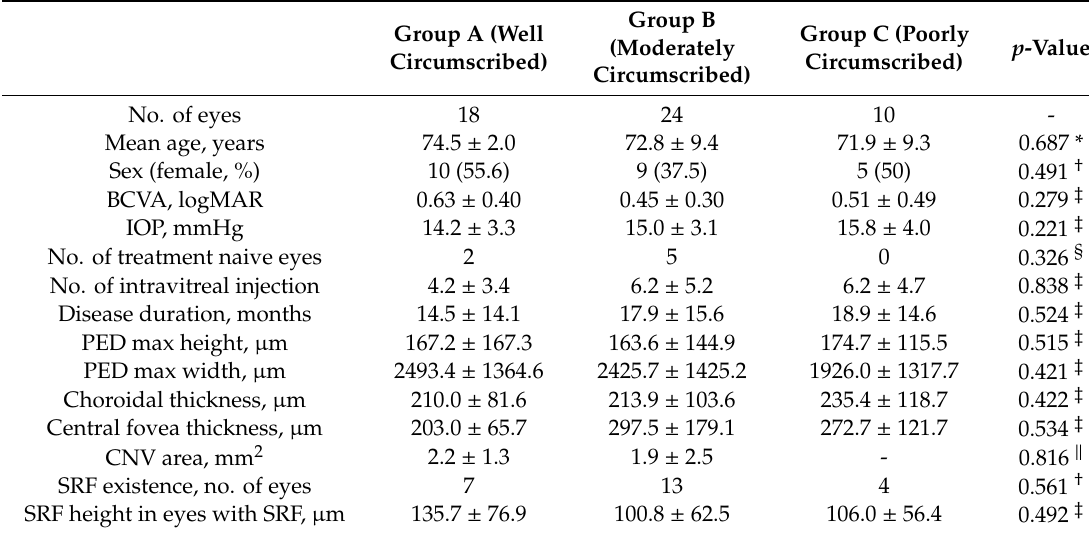
Table 2. Classification of eyes with neovascular age-related macular degeneration according to detection group of choroidal neovascularization (CNV).